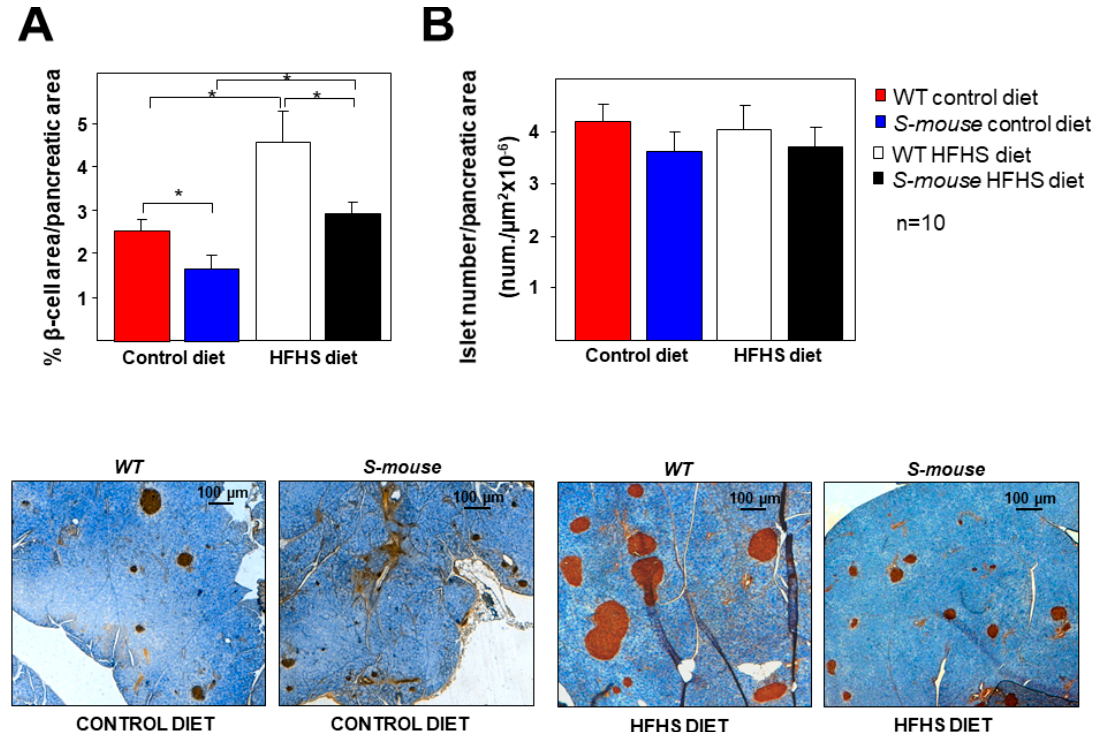
Figure 3. Pancreatic islet characterisation in WT and S-mice fed high-fat, high-sucrose or control diet for 16 weeks. ( A ) Quantification of β -cell area (in percentage relative to pancreatic area) and ( B ) relative islet number in the pancreas of all groups of mice identified by anti-insulin immunohistochemistry. Representative images of the immunohistochemistry are shown. Data are presented as mean ± SEM. Statistical analysis was performed using one-way ANOVA. * p ≤ 0.05 . HFHS high-fat, high-sucrose. These results indicate that the di ff erences in insulin secretion were due to di ff erences in β -cell mass and not to the number of